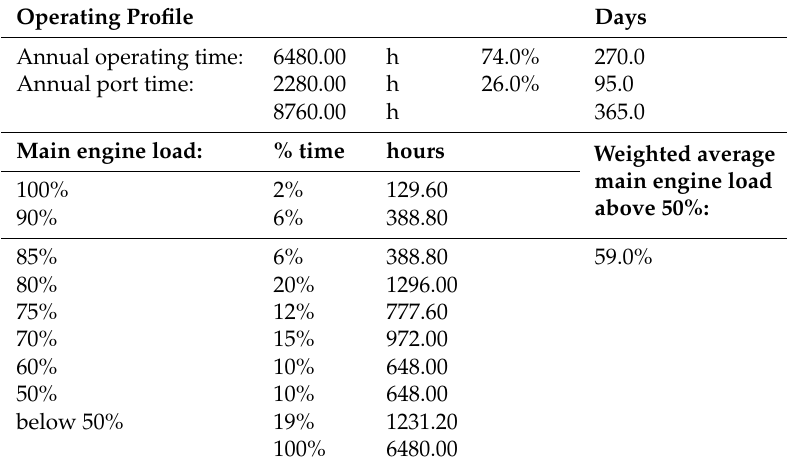
Table 2. Annual distribution of engine